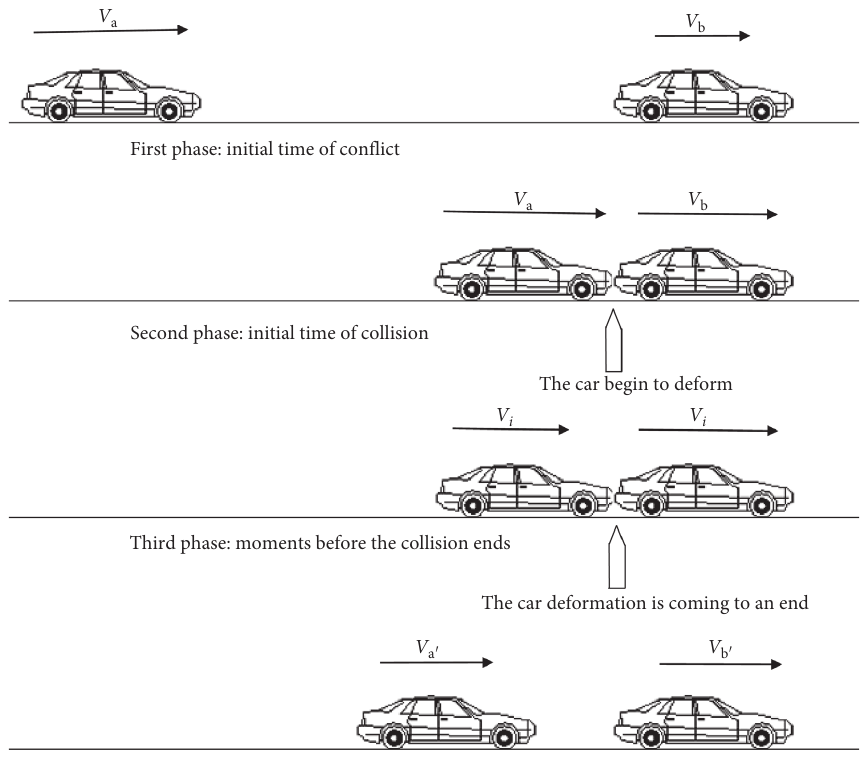
Figure 1: Schematic diagram of speed changing during vehicle